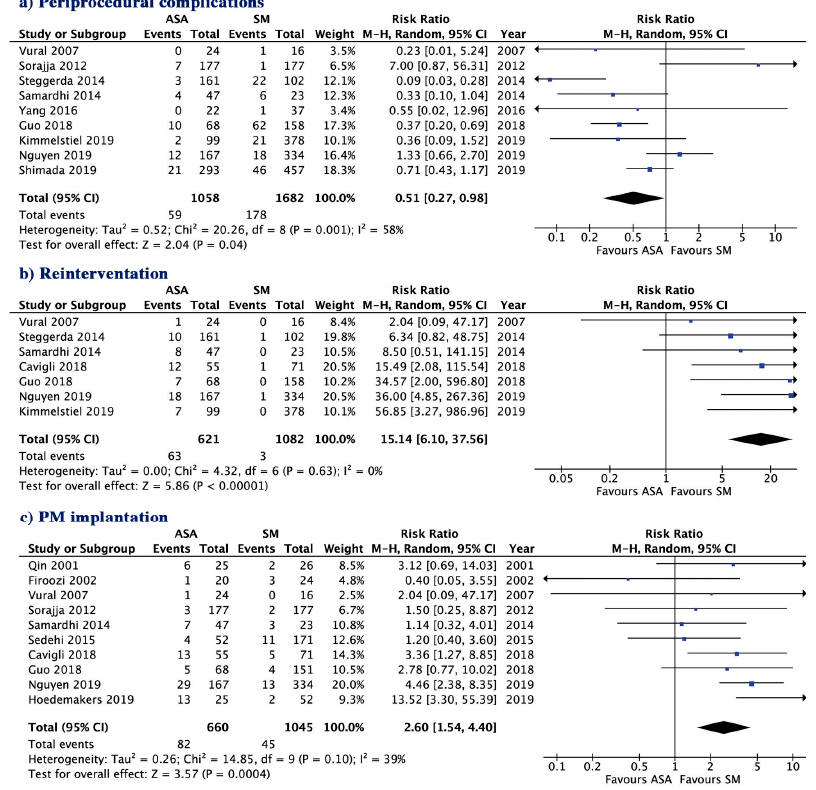
Figure 2. Risk ratio of outcome with septal ablation versus surgical myectomy, ( a ) cardiovascular mortality; ( b ) sudden cardiac death (SCD). ASA, alcohol septal ablation; SM, surgical myectomy; CI, confidence interval. ( c ) Stroke.